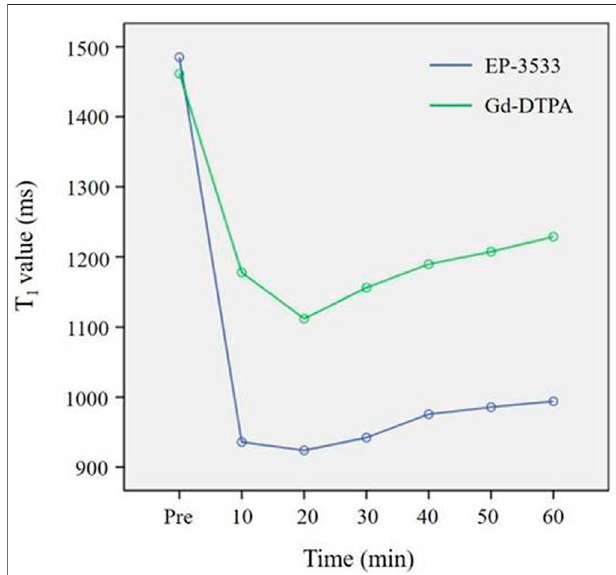
FIGURE2| Change in T 1 values from the bowel wall according to the time stream after the injection of EP-3533 and Gd-DTPA. To generate longitudinal relaxation rate maps, a series of dual fl ip-angle (2 ° and 12 ° ) three-dimensional (3D) gradient echo sequences were also acquired before and 10 min, 20 min, 30 min, 40 min, 50 min and 60 min following the intravenous administration of EP-3533. The image acquisition parameters comprised the following: TE = 3.6 ms; TR = 8.6 ms; fi eld of view (FOV) = 52 mm × 70 mm; matrix =192 × 256; slice thickness = 2.0